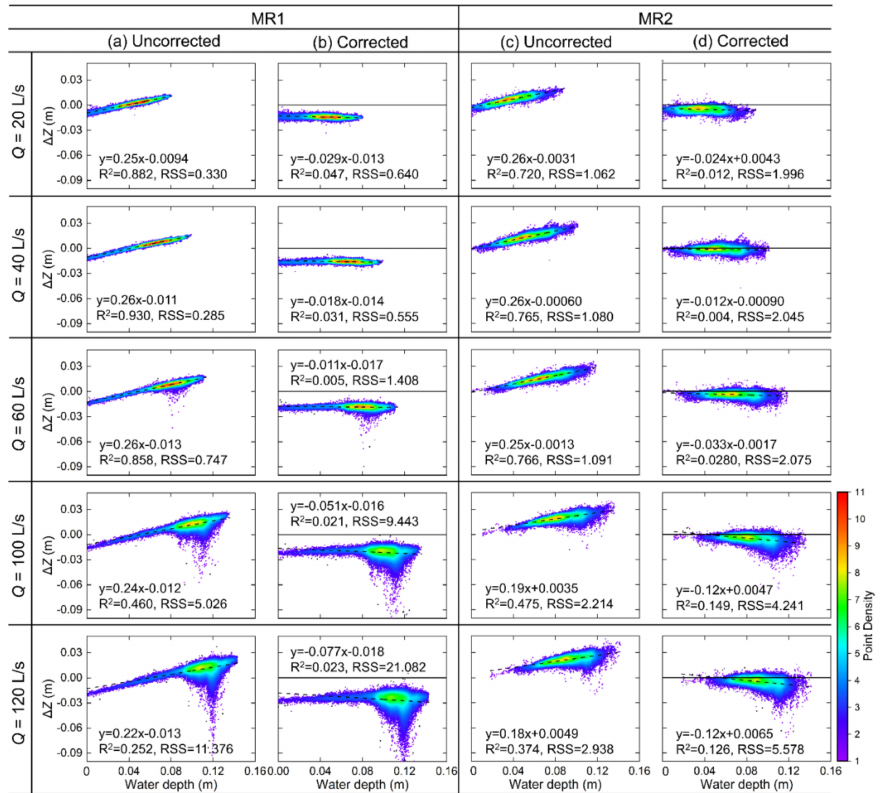
Figure A5. Relations between water depth and elevation error for the models using all the GCPs in the two monitored reaches: ( a , b ) for the uncorrected and corrected models for MR1, respectively; ( c , d ) for the uncorrected and corrected models for MR2, respectively Point density refers to the point number at each plotted point location. RC is short for refraction correction. Linear regression for each relation is presented with the regression equation, R-square, and residual sum of squares